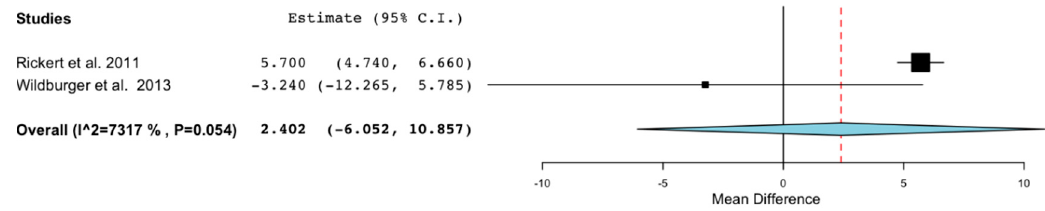
Figure 3. Forest plot of new bone formation between control vs. grafts with application of stem cells in maxillary sinus regenerations.